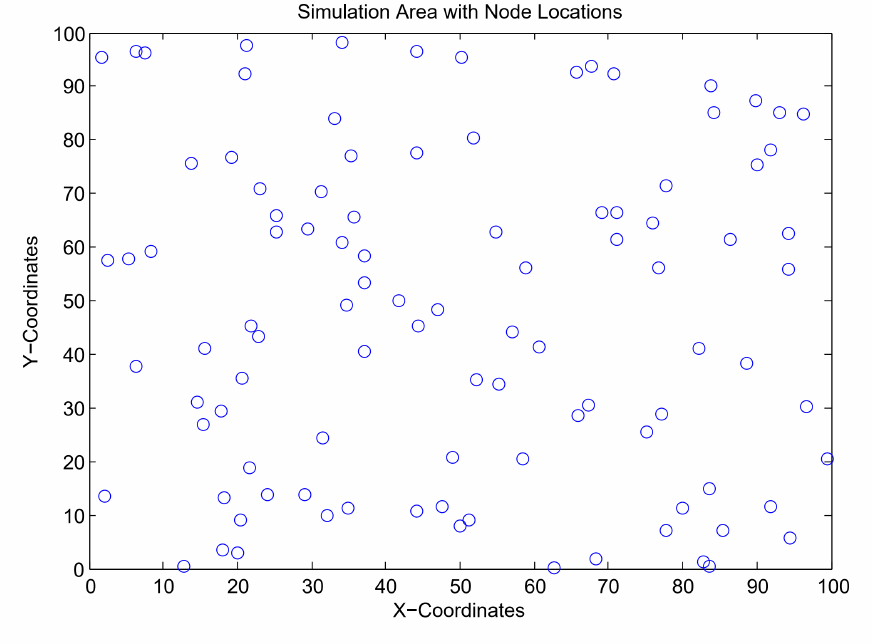
Figure 6. Simulation Area with Node